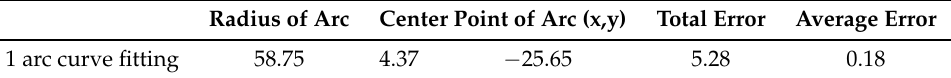
Table 3. Piecewise curve fitting result of the phantom (mm).